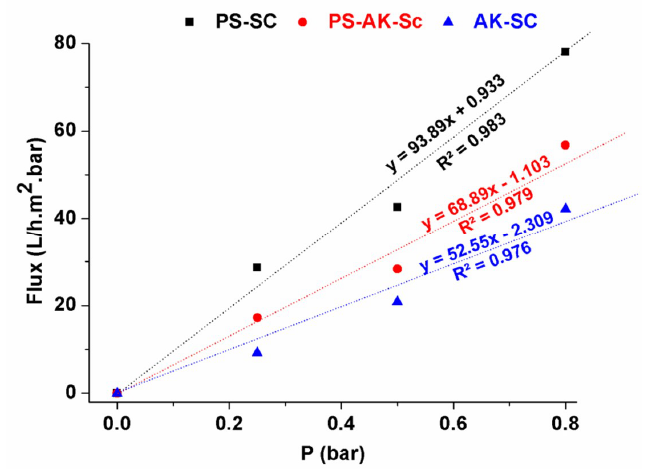
Figure 11. Variation of water flux as a function of transmembrane pressure.